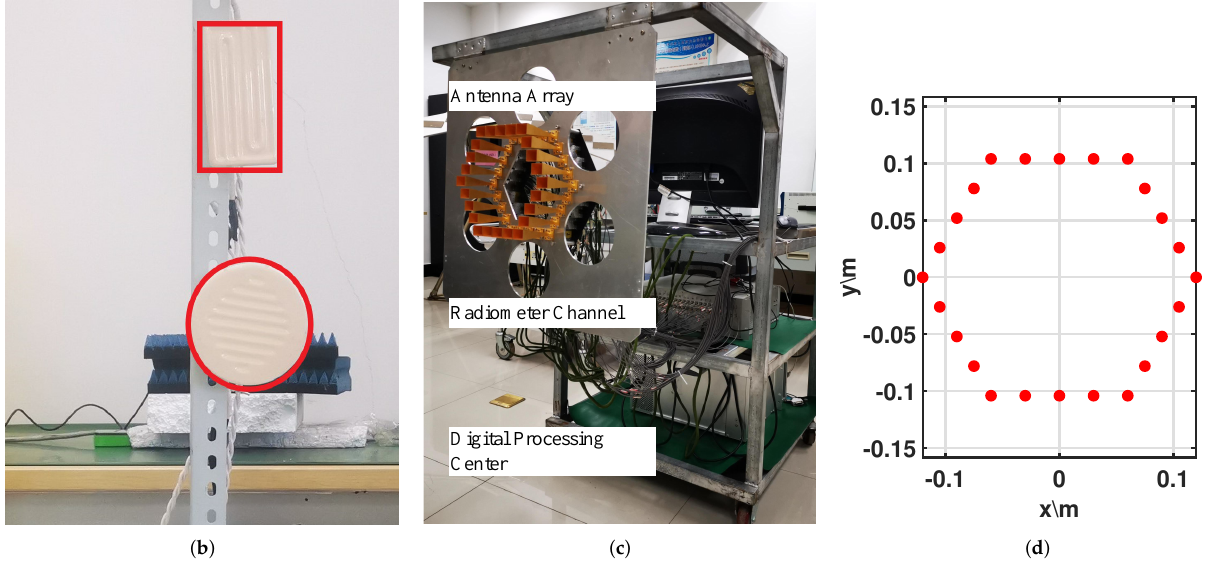
Figure 10. The pictures of real imaging experiments. ( a ) Experimental scenario; ( b ) photograph of real extended source; ( c ) photograph of SAIR system; ( d ) hexagonal antenna array structure.